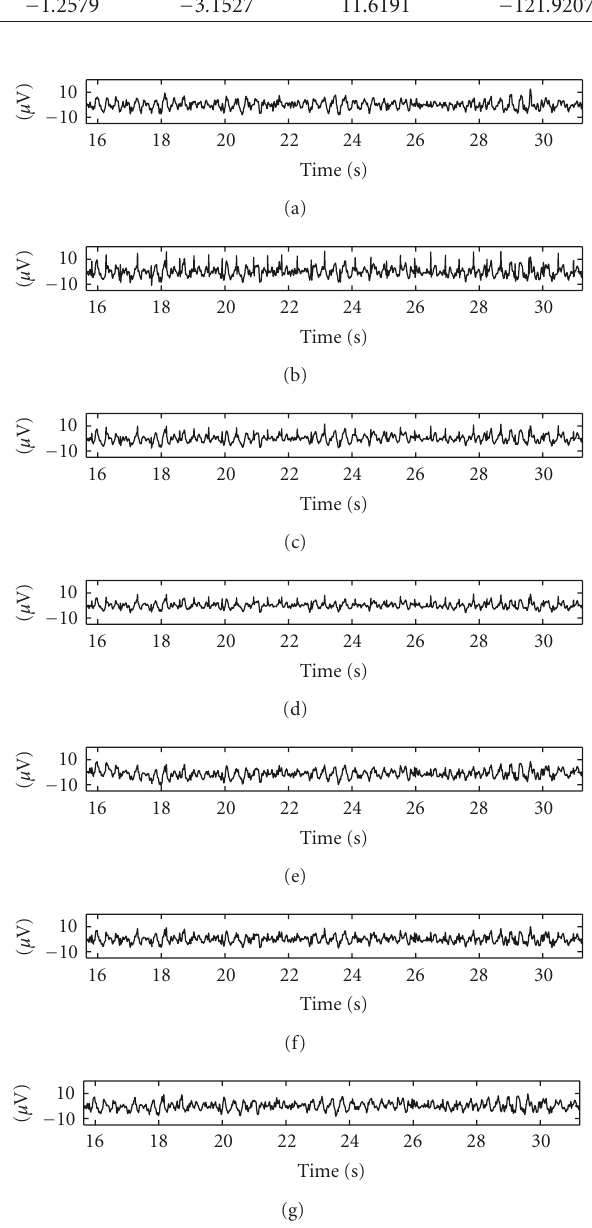
Figure 9: ECG interference removal in EEG. (a) Original EEG, (b) EEG containing ECG interferences, (c) OSR (MSE = 4.1883), (d) adaptive OSR (MSE = 3.3599), (e) BOSR (MSE = 2.7189), (f) adaptive BOSR (MSE = 2.3354), (g) RBOSR (MSE =